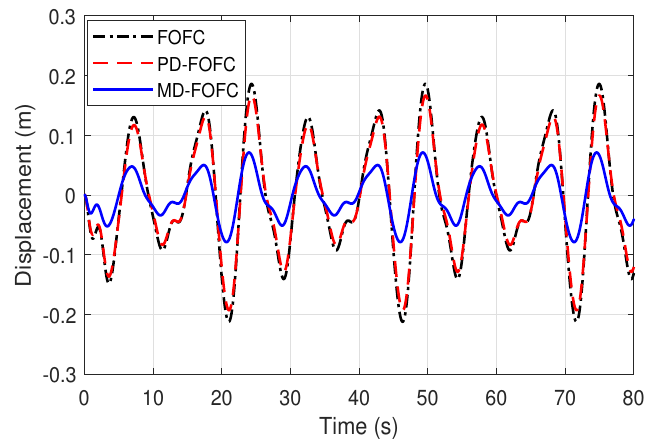
Figure 5. Displacement of the structure with FOFC, PD-FOFC, and MD-FOFC.